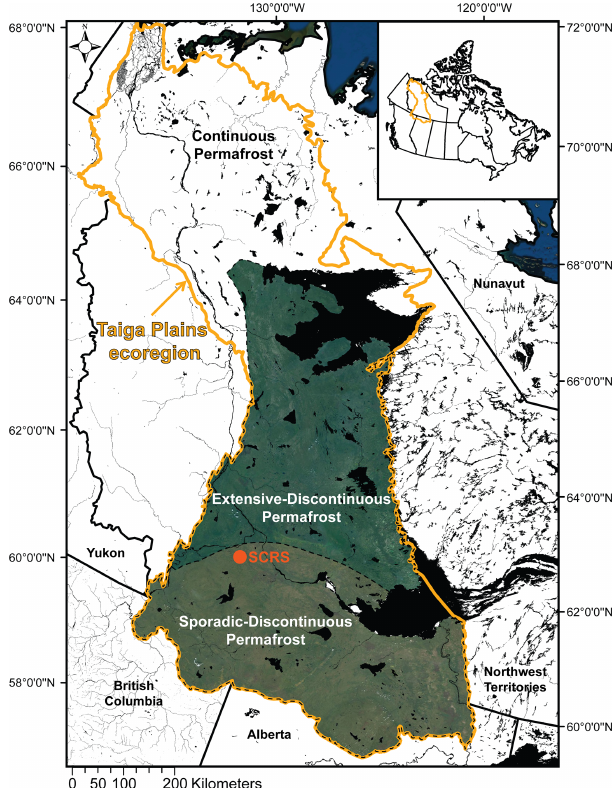
Figure 1. The Taiga Plains ecoregion with the discontinuous per- mafrost zones (coloured) defining the study region (Brown et al., 2002). The location of Scotty Creek Research Station (SCRS) is also indicated. This figure contains information licensed under the Open Government Licence –